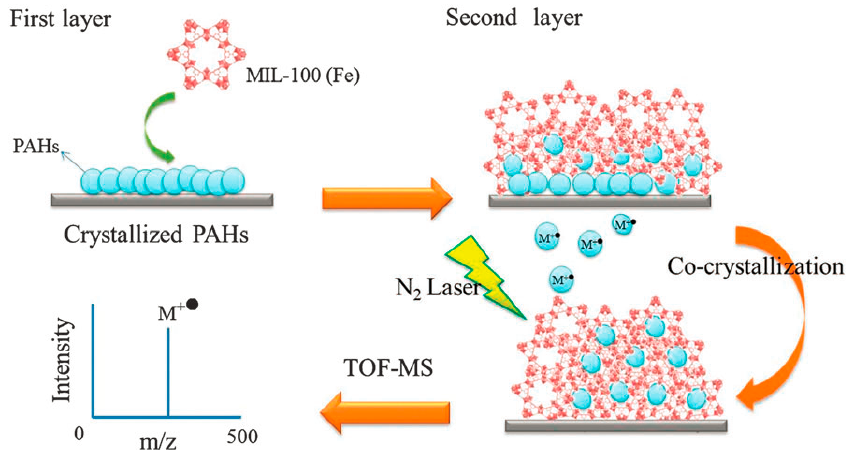
Figure 2. Laser desorption/ionization-mass spectrometry (LDI-MS) process using porous metal organic frameworks (MOFs) as matrices. Reproduced with permission of [75].